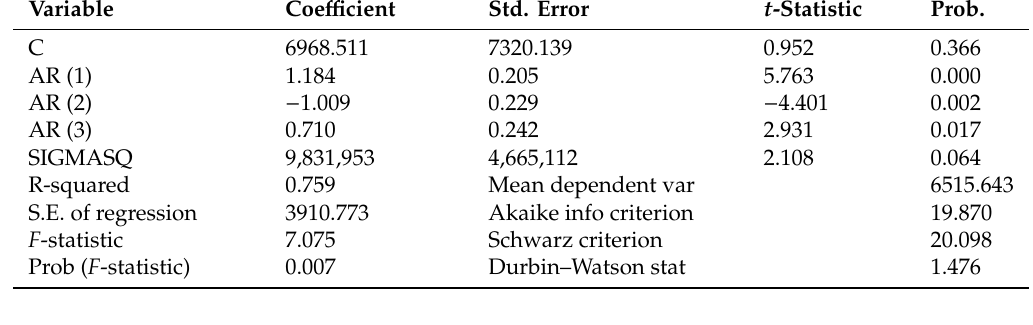
Table 1. Coe ffi cient covariance computed using outer-product-of-gradients (OPG) of Alpha rice Table 1. Coefficient covariance computed using outer-product-of-gradients (OPG) of Alpha rice